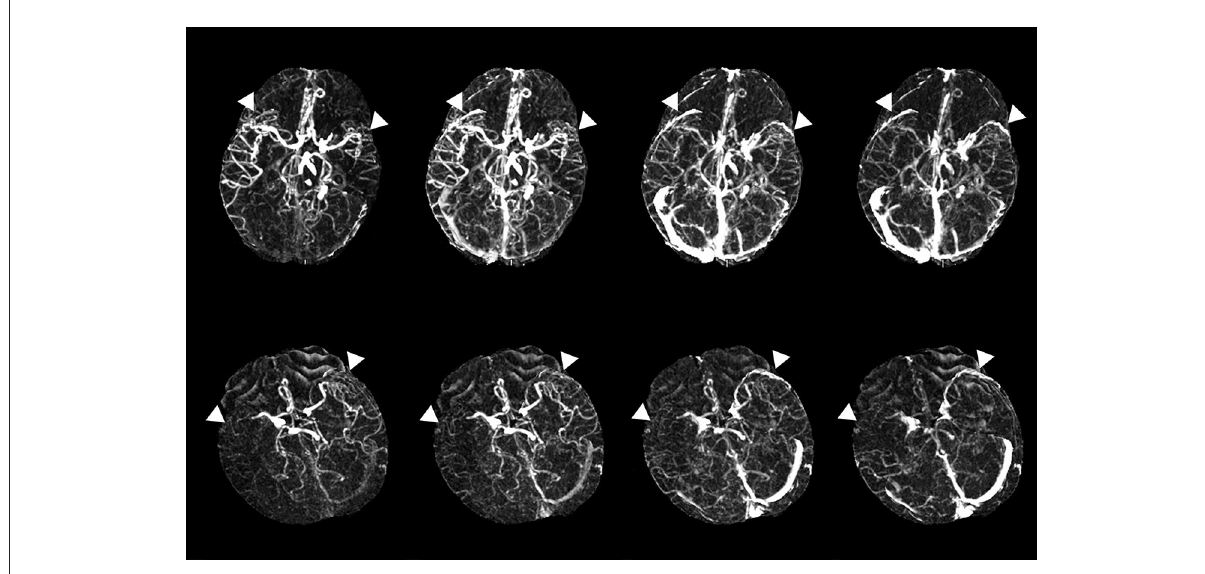
FIGURE1 Examples of delayed superficial middle cerebral vein (SMCV) (the upper line) and absent filling of the ipsilateral superficial middle cerebral vein (SMCV-) (the lower line) . White triangles point to the